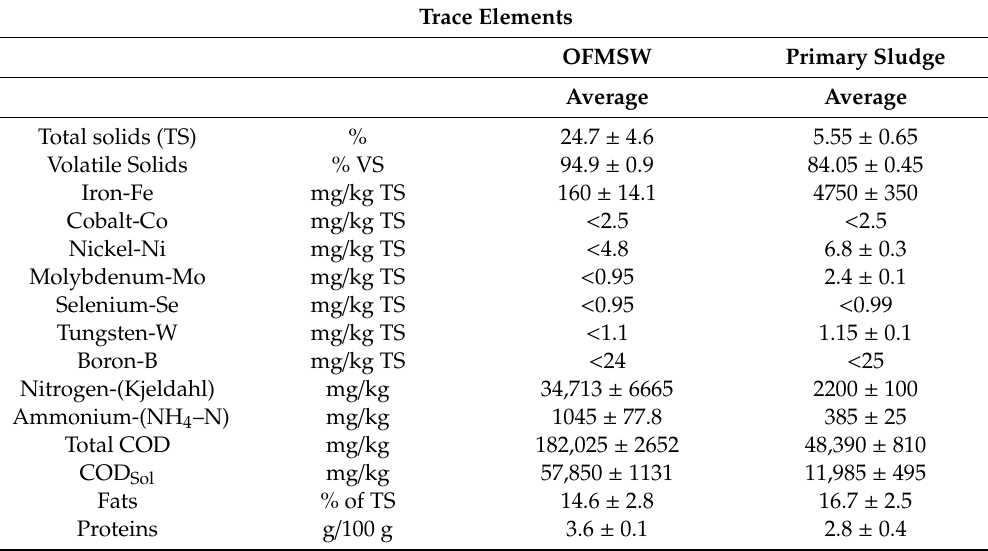
Table 1. Substrate characterization. Trace element and nutrients composition in the substrates. Trace